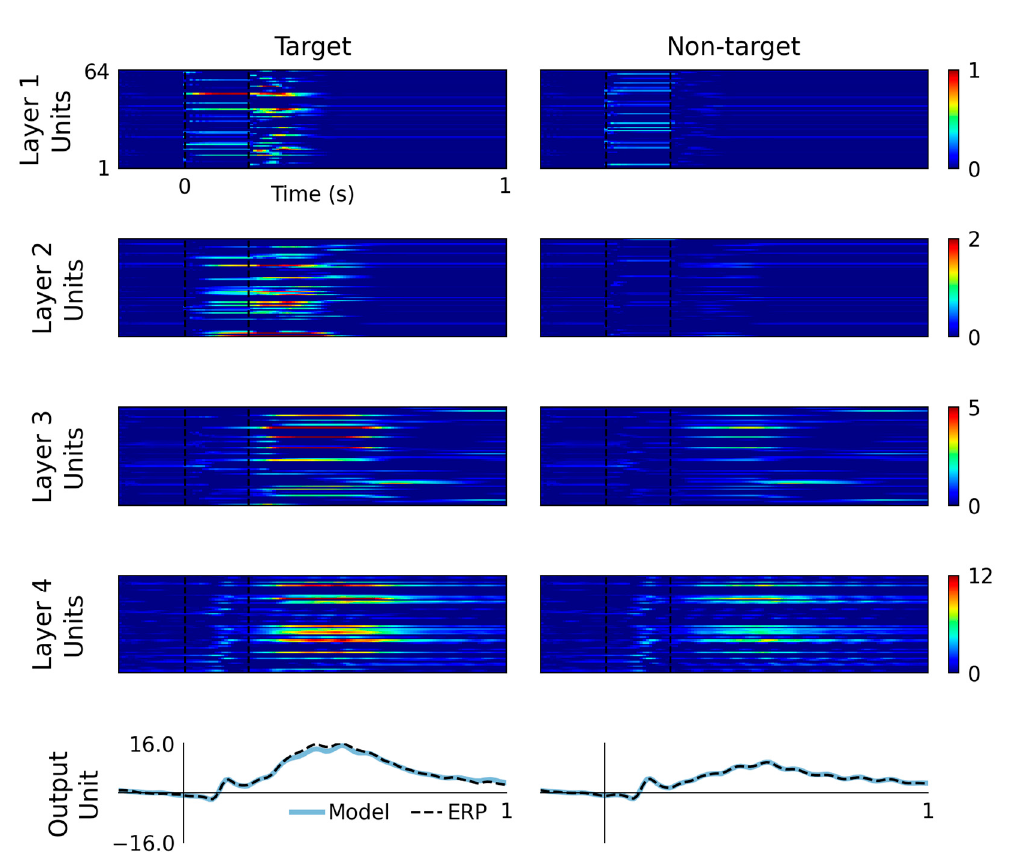
Figure 3. Model outputs and hidden layer activations are plotted by layer and input condition. These graphs display the pattern of information flow through the RNN, from layer 1 through to layer 4, with increasing complexity and latencies of activity, culminating in model outputs plotted alongside grand-average ERP waveforms. Target events evoke a higher magnitude response from the earliest processing layers, which leads to a higher magnitude response over the P3 latency range of 0.3 to 0.6 ms.